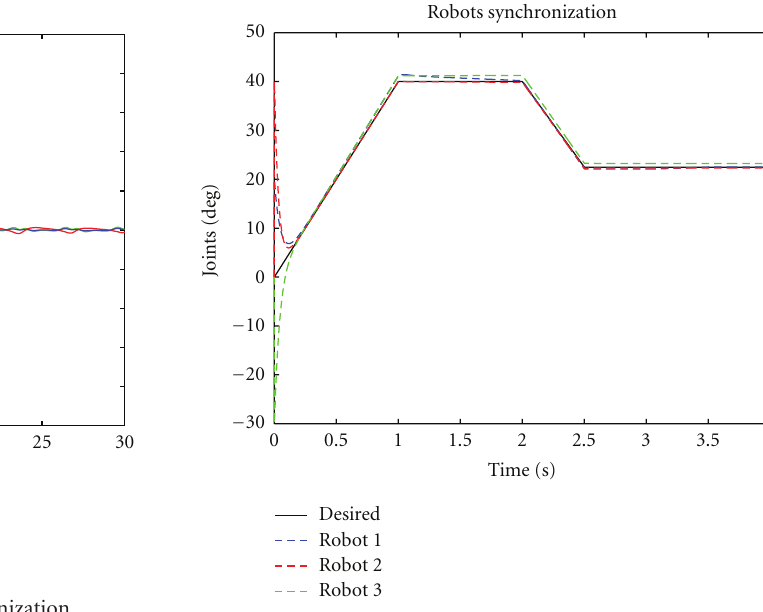
Figure 6: Robots synchronization without time delay.